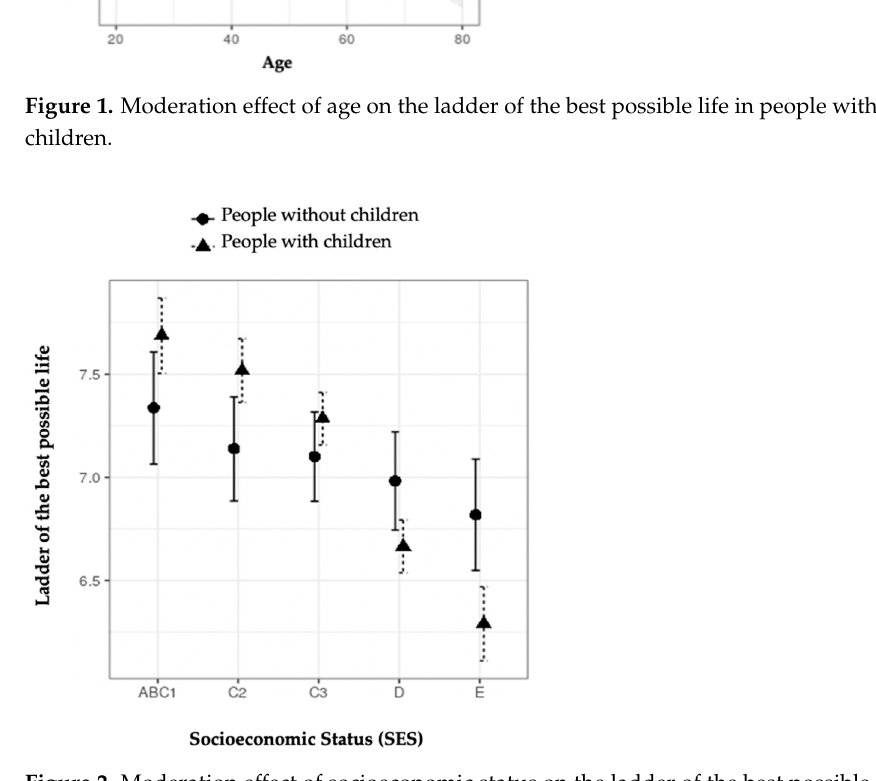
Figure 2. Moderation effect of socioeconomic status on the ladder of the best possible life in people with and without children.